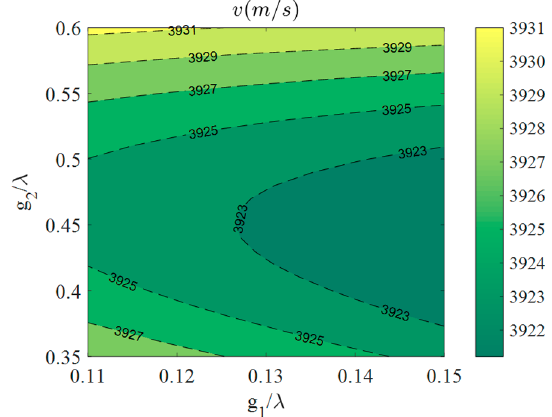
Figure A1. Contour of v as a function of g 1 and g 2 . The magnitude of the normalized reflectivity with an electrical period λ is shown in Figure A2.